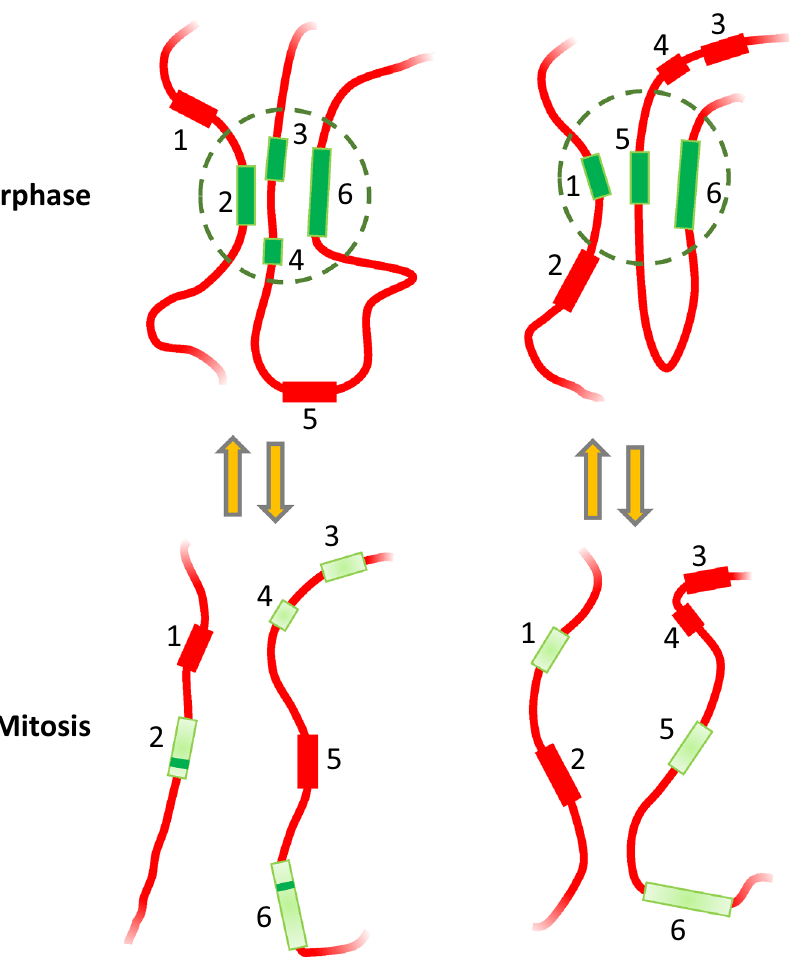
Figure 8. Cell-type-specific patterns of histone acetylation persist through the cell cycle and may guide the reformation of functional chromatin domains as cells leave mitosis. The coloured rectangles numbered 1–6 indicate chromosomal regions within the 5–1000 Kb size range that are marked by relatively high levels of histone acetylation (shown in green) in at least one of the two cell types studied (LCL and HeLa). Such regions are referred to in the text as sub-bands. Intervening chromatin showing a consistently low level of acetylation is shown in red, as are sub-bands that are weakly acetylated in one cell type or the other. Sub-bands 1–2 and 3–6 may be on the same or different chromosomes. In interphase, highly acetylated sub-bands can associate to form functional domains (dashed circles) that differ between cell types. Functional domains may be characterised by a particular level of transcriptional activity. At least some functional domains dissociate through mitosis, much as TADs are known to do. There is a global fall in histone acetylation as cells move through mitosis, but our results show that the highly acetylated sub-bands that characterize each cell type remain relatively highly acetylated in mitotic cells (shown in pale green). In addition, some genes (e.g. all Ribosomal Protein genes so far tested in HeLa cells) seem to escape global deacetylation, thus showing up as particularly highly acetylated in metaphase (marked as narrow transverse strips in sub-bands 2 and 6 in Cell Type I only). We suggest that the relatively high levels of histone acetylation, and perhaps other histone PTM, within particular sub-bands form part of a mechanism that guides the reformation of cell-type-specific transcriptional domains, and hence patterns of gene expression, as cells leave